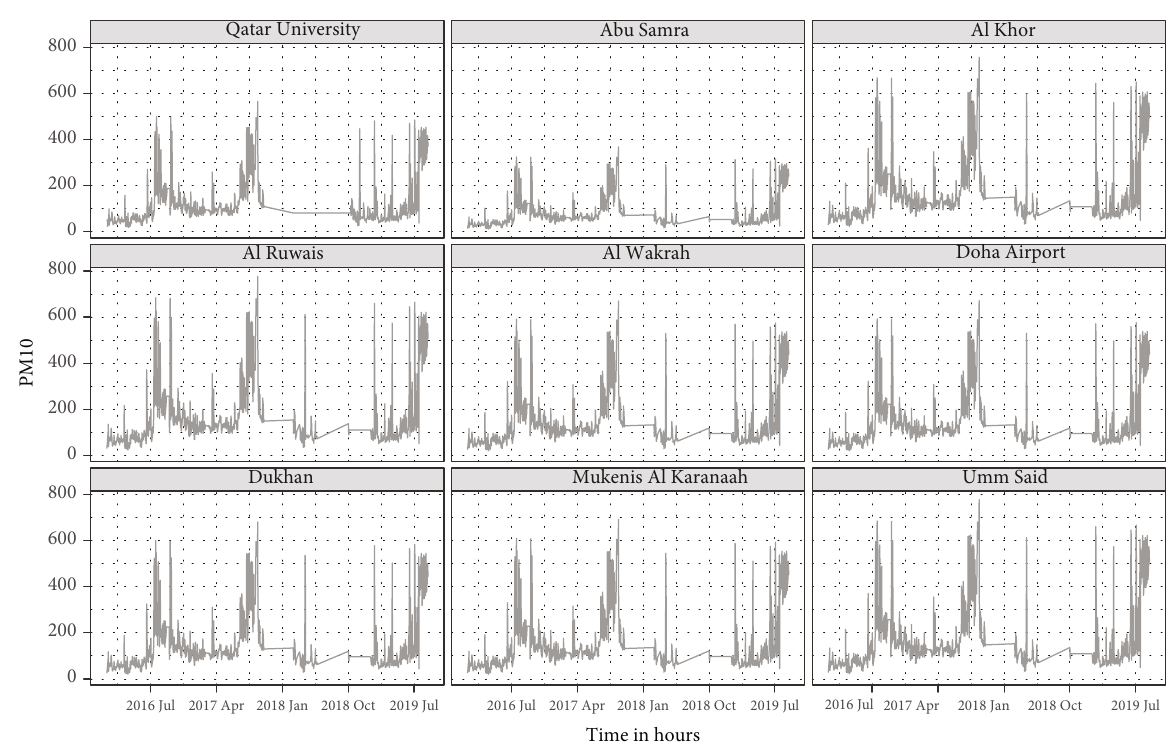
Figure 2: Daily PM concentrations observed in nine locations over the years 10